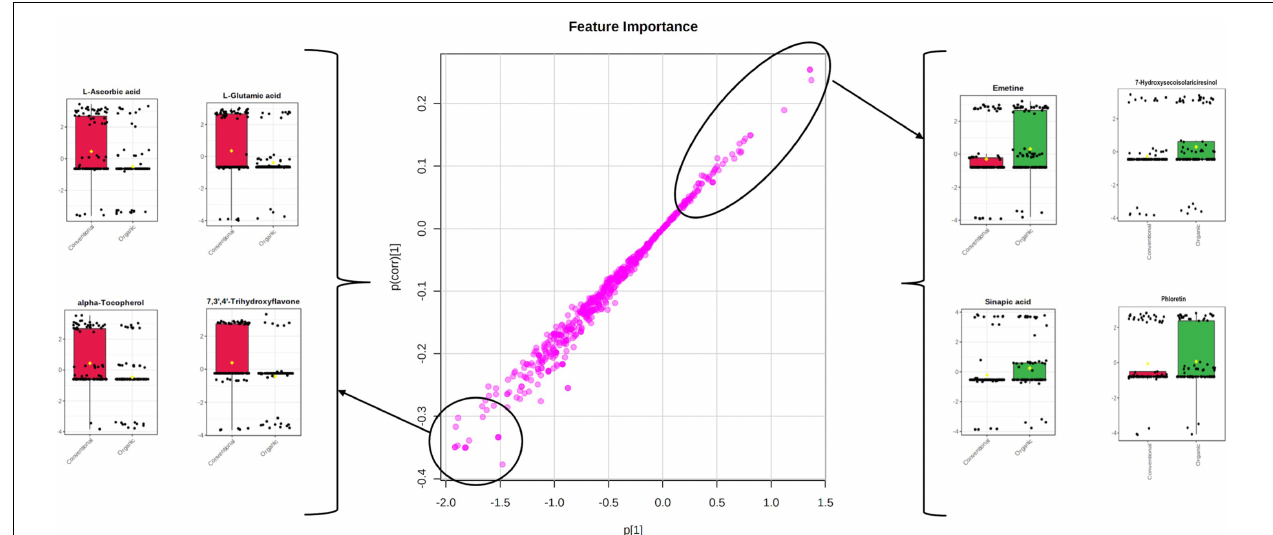
FIGURE 4 | S-plot following the orthogonal projections to latent structures discriminant analysis (OPLS-DA) model on the different farming systems. The most discriminant features are highlighted, together with their Log2 fold-change